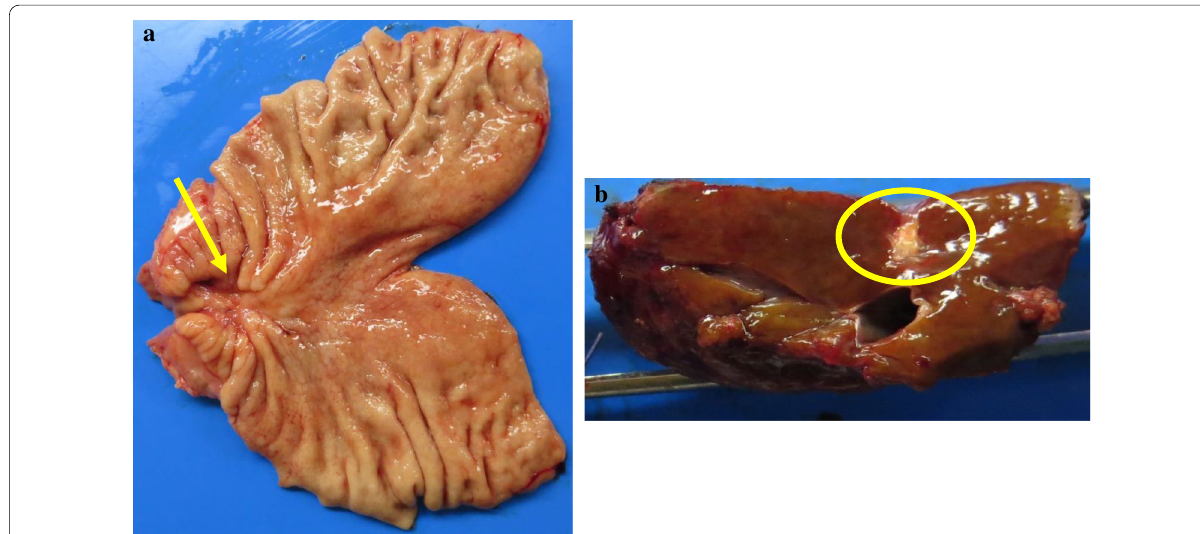
Fig. 4 Macroscopic findings of resected organs. a Stomach; a type 2 lesion was detected macroscopically in the gastric antrum (red arrow). b Liver;